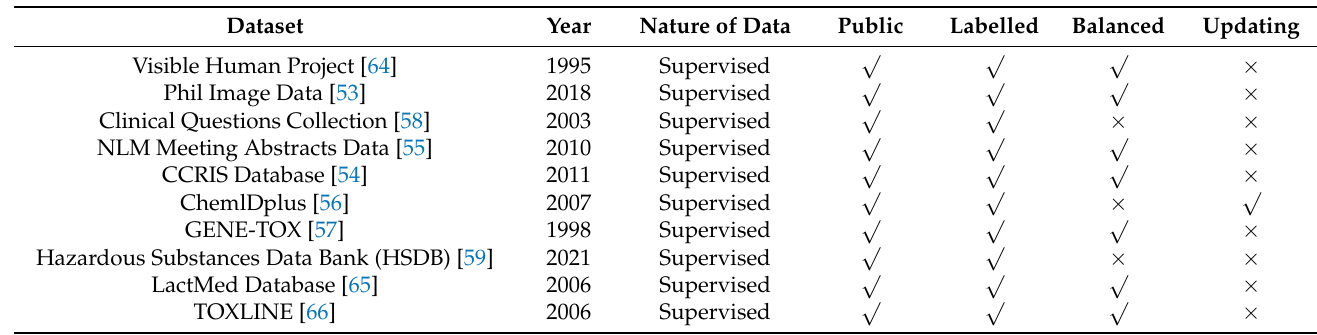
Figure 13. The bar chart representation of the distribution of literature of various immunology subdomains.